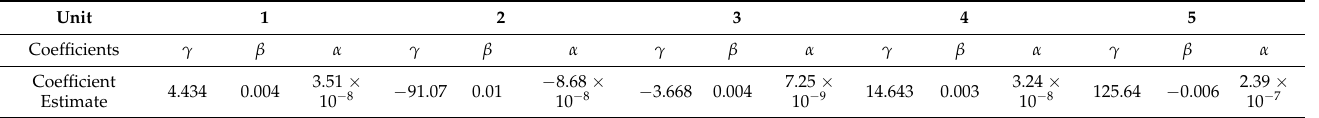
Table 4. Estimated parameters for O/I characteristics of generators.